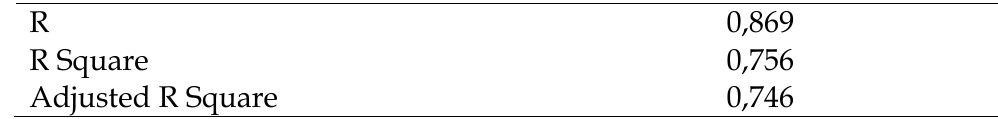
Determination Coefficient Test